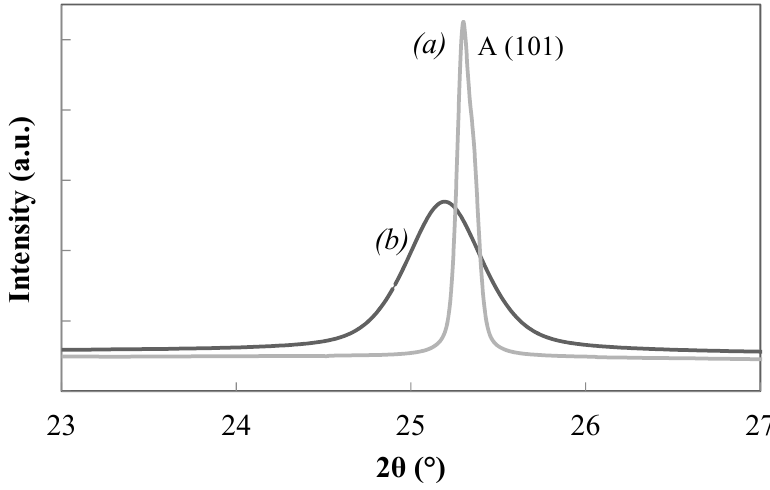
Figure 10. Anatase peak (101) of pure titania ( a ), T9 sample in Table 2, and of titania–zirconia (5 mol %) solid solution ( b ), sample H in Table 3, both calcined at 450 °C.